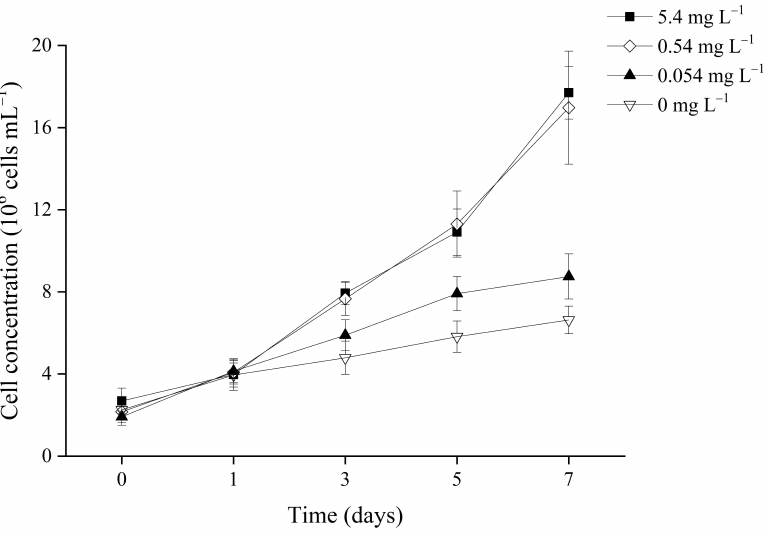
Figure 1. Changes in cell concentration in cultures of Microcystis aeruginosa FACHB-905 at different initial phosphorus concentrations. Lines with different symbols represent different initial phosphorus concentrations. Error bars indicate standard deviation from three biological